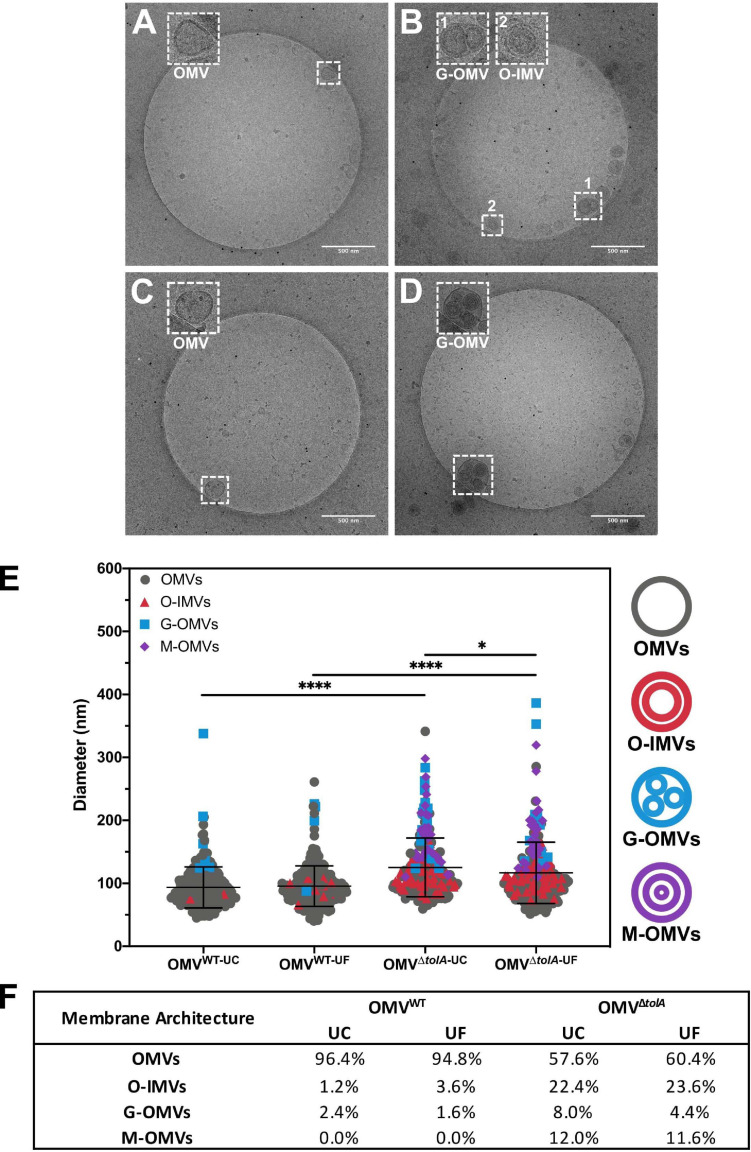
Cryo-TEM images of vesicle types in WT and ΔtolA strains. Representative cryo-TEM images at 14,500× magnification of WT OMVs isolated by UC (A), WT OMVs isolated by UF (B), ΔtolA OMVs isolated by UC (C), ΔtolA OMVs isolated by UF (D). In each panel, enlarged images of representative OMVs frequently observed (based on table values shown in panel F) in WT and ΔtolA are highlighted as inset panel images in dashed boxes in the upper left-hand corner. Conventional OMVs as well as vesicles with two membranes (O-IMVs) and multi-layered vesicles (M-OMVs, G-OMVs) are shown in these inset images in panels (A–D). (E) Scatter plot summaries of vesicle diameters measured from cryo-TEM images of OMVs isolated from the WT and ΔtolA strains using either ultracentrifugation (UC) or ultradiafiltration (UF) at N = 250 vesicles/strain. Lines on each plot represent the mean value, and error bars represent standard deviations. Diameters of vesicles from cryo-TEM images were measured using ImageJ particle analysis software. Shape and color of data points represent the types of vesicle visualized (refer to in panel legend). Significance was determined using Mann–Whitney U test ∗p < 0.01, ****p < 0.0001, N = 250 vesicles). (F) Summary table of membrane vesicle architectures manually identified from cryo-TEM images using ImageJ. Values listed in the table represent the percent total number of vesicles manually assessed representing each shape/architecture type (N = 250 vesicles/strain).